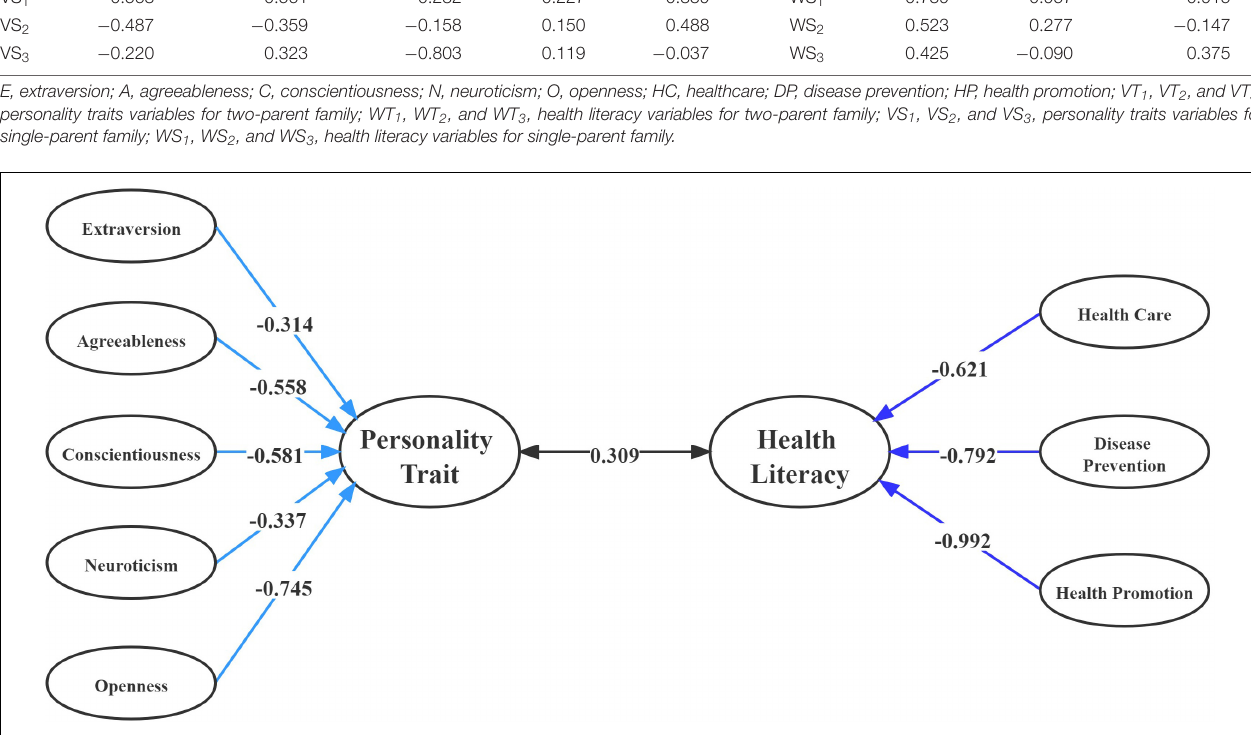
FIGURE 1 | Correlations between variables set of personality traits and variables set of health literacy and among their canonical variables in two-parent